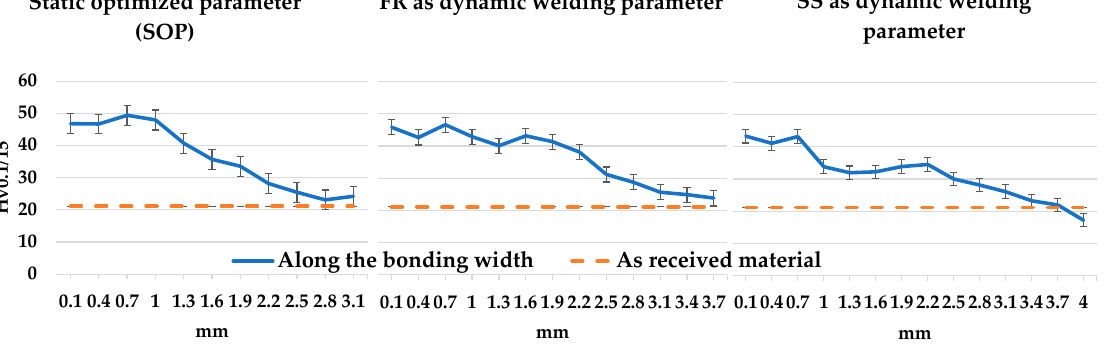
Figure 13. Microhardness results along the bonding width direction. The error bars show the maximum and the minimum value of the measurements.